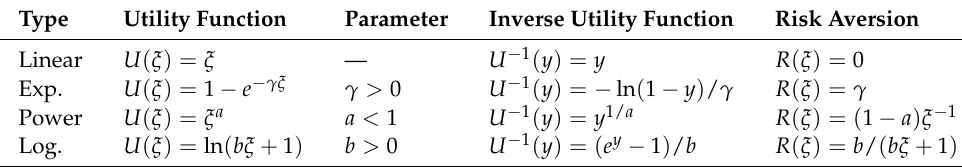
Table 1. Utility functions, their inverse functions and risk aversion functions. Type Utility